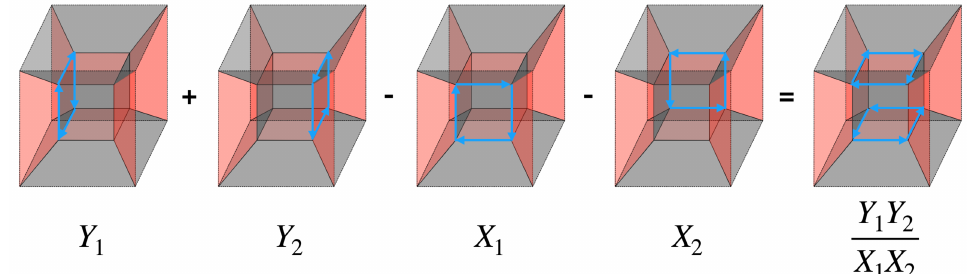
Figure 9 . Example of the brick variable for the internal brick of the cube model in terms of oriented edges. When combining oriented faces, we will interchangeably talk about their addition/subtraction and multiplication/division depending on the context. We will use the former when referring to the combination of the faces in G and the latter when discussing the corresponding variables.